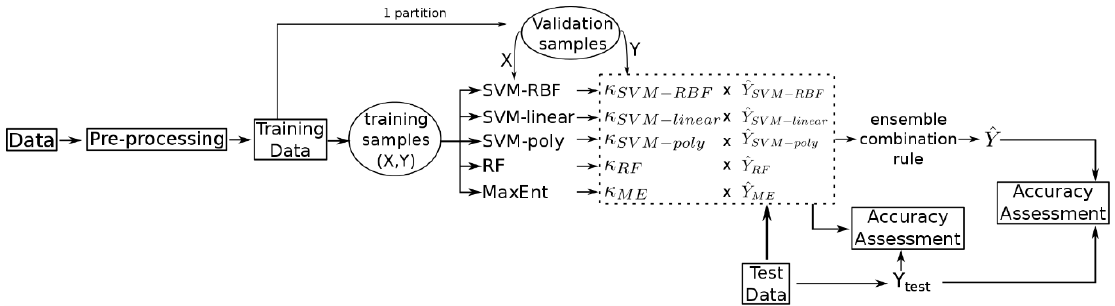
Figure 2. Overview of the ensemble classifier system. X represents the features extracted during pre-processing, Y and Y test represent ground truth of training and test data, ˆ Y class is the prediction of a classifier and ˆ Y the ensemble prediction. K class is the kappa obtained by a classifier.